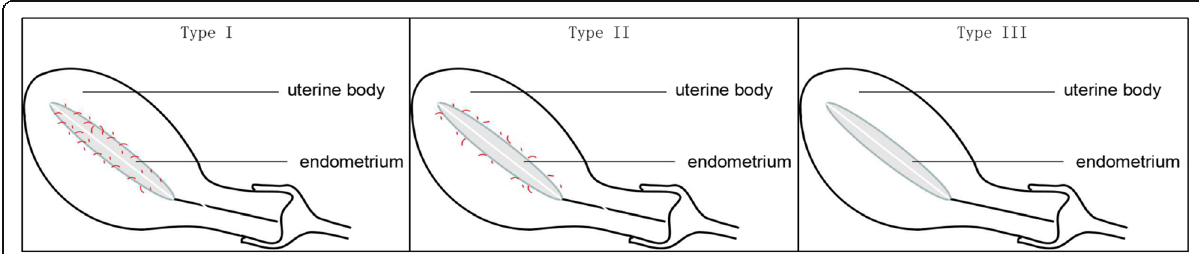
Fig. 2 Endometrial blood flow patterns. Red lines indicate blood flow. Type I: blood flow is present in the endometrium and subendometrium; type II: blood flow is absent in the endometrium, but present in the subendometrium; type III, blood flow is not observed in both endometrium and subendometrium